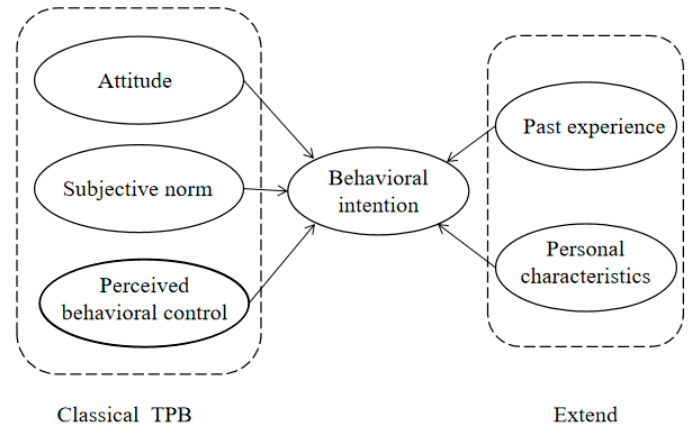
Figure 1. Based on the classical TPB extended theoretical framework.